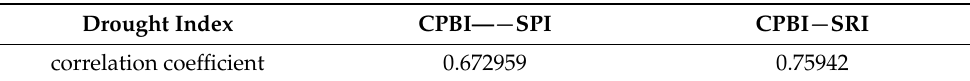
Table 7. Statistical tables of Pearson correlation coefficients for the three drought indices at Huaxian station.